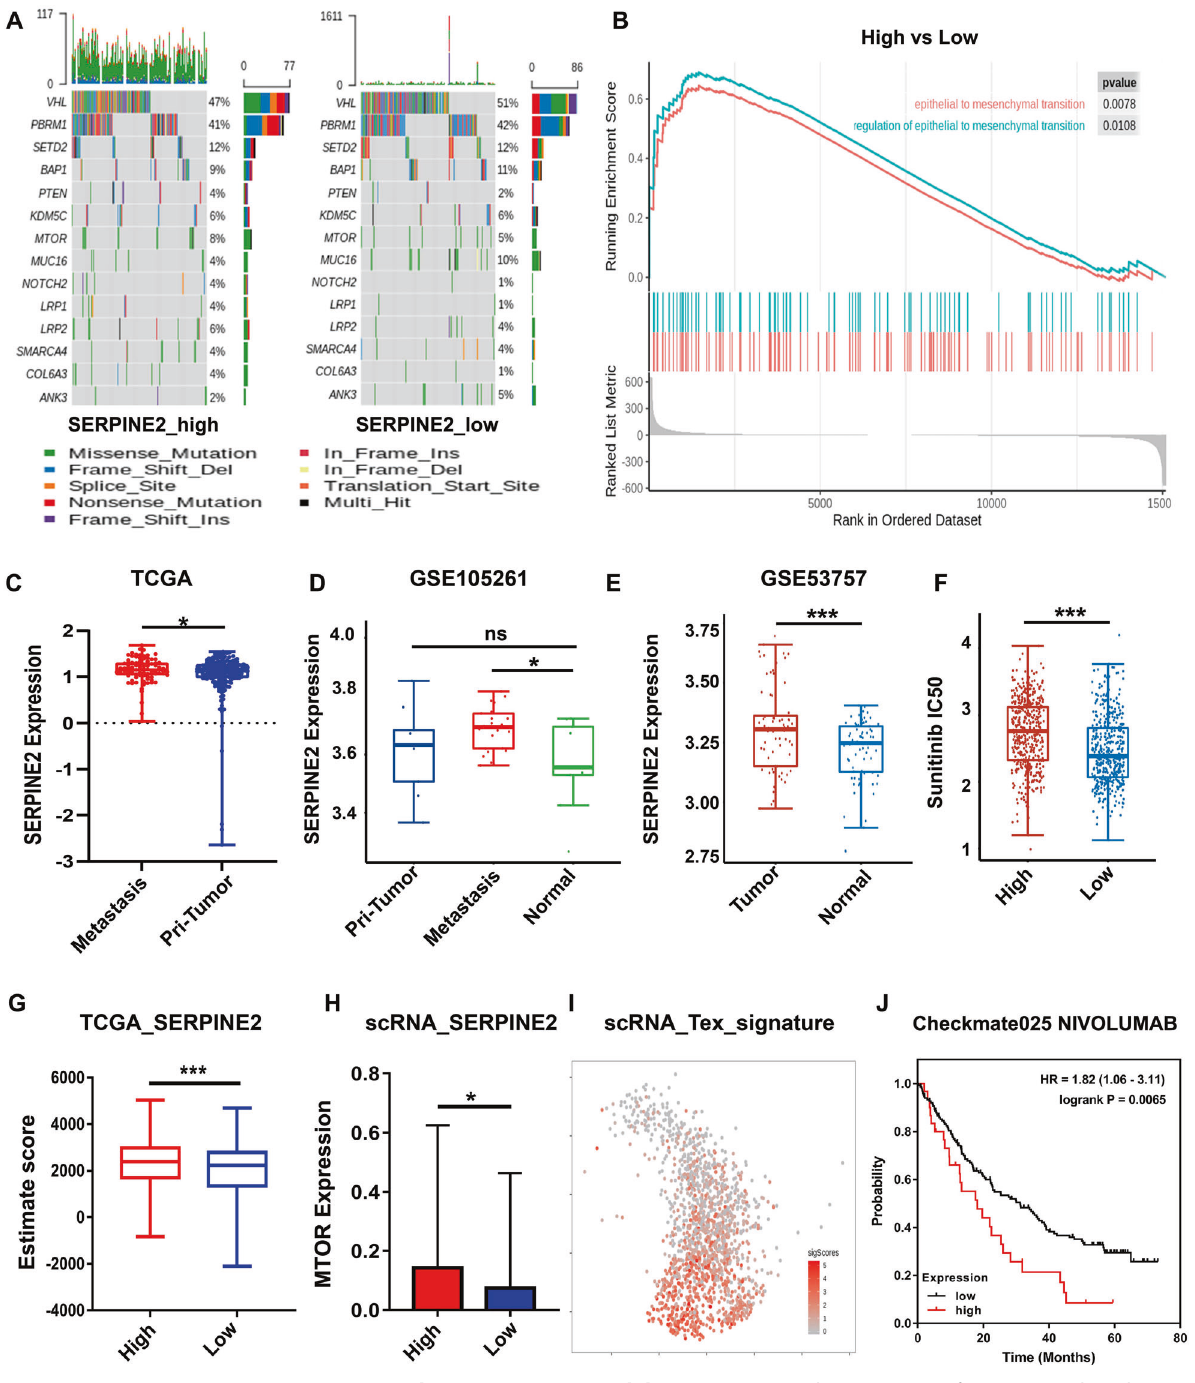
Fig. 4 SERPINE2 serves as a metastasis-associated oncogene in RCC and drug response. A The Oncoprint of conventional marker genes of RCC with alterations in SERPINE2 high and low groups. Tumor mutation burden is represented for individual samples as a bar chart above the oncoprint. B The GSEA plot shows enrichment of EMT-related pathways in SERPINE2 high group in TCGA. FDR < 0.05 is considered as signi fi cantly enriched. C SERPINE2 expression between tumor tissues from patients with metastasis (positive N stage or M stage >0, n = 89) and from patients with no metastasis (N stage or M stage = 0, n = 199). Data seen in Table S10. D SERPINE2 expression among primary ( n = 9), metastatic tumors ( n = 26) and normal tissues ( n = 9) in GSE105261. Data were obtained from https://www.aclbi.com/static/index.html#/geo. E SERPINE2 expression between tumors ( n = 72) and normal tissues ( n = 72) in GSE53757. Data were obtained from https://www.aclbi.com/ static/index.html#/geo. F IC50 prediction of sunitinib for SERPINE2 high and low groups in TCGA, based on the GDSC database. G The estimate score of tumor tissues from SERPINE2 high and low groups, re fl ecting the immune in fi ltration. H MTOR expression from cells in scRNA-seq analysis (50%: 50%). I UMAP plot shows the terminally exhausted CD8 + T cell signature expression. J The KM survival curve of SERPINE2-high and SERPINE2-low groups in the cohort of clinical trials Checkmate025 with Nivolumab. * p < 0.05; ** p < 0.01; *** p < 0.001.